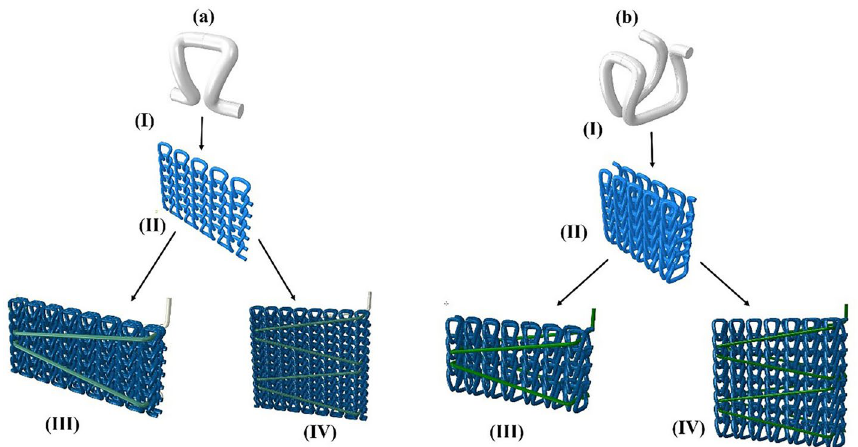
Fig. 1 Procced of the finite element modeling. a Plain structure, (I) knit loop, (II) plain fabric, (III) T1 unit-cell, (IV) T1 with two unit-cells. b Rib structure, (I) knit loop, (II) rib fabric, (III) T3 unit-cell, (IV) T3 with two